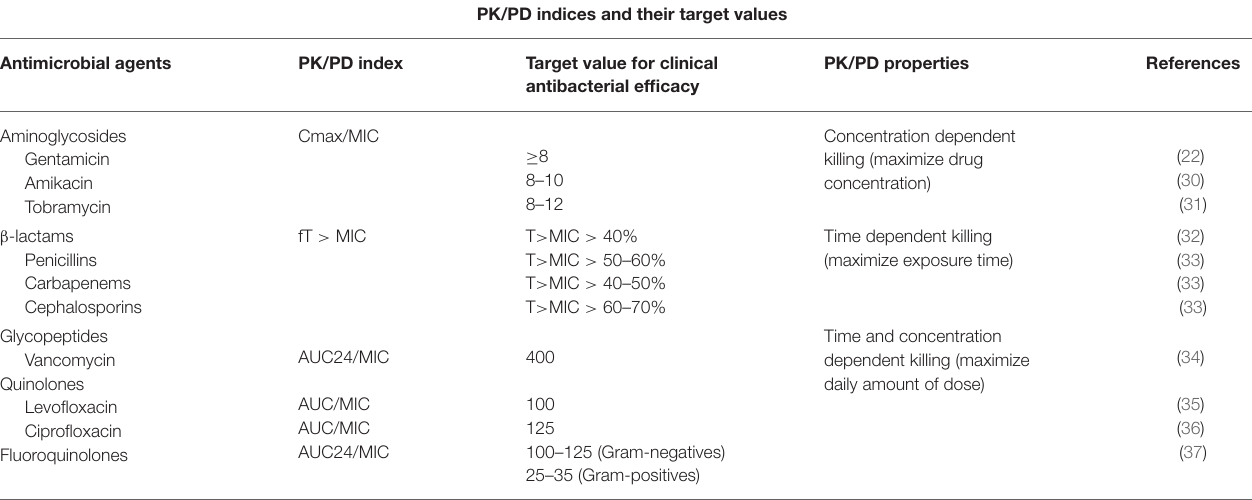
TABLE 1 | Pharmacokinetic and pharmacodynamic indices for antimicrobial agents together with their target value and bactericidal characteristics. PK/PD indices and their target values Antimicrobial agents